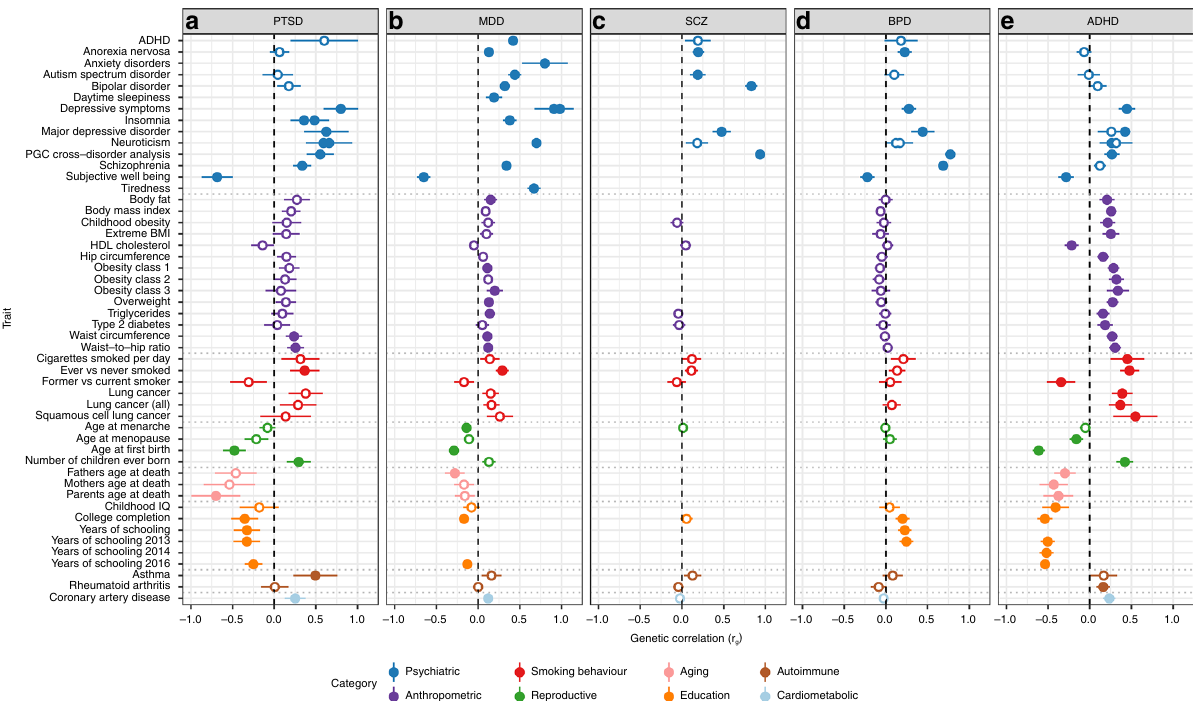
Fig. 3 Commonality of genetic correlations between PTSD and other psychiatric disorders and traits with GWAS summary statistics on LD Hub. Psychiatric traits include a PTSD, b MDD, c SCZ, d BPD and e ADHD and their genetic correlations with traits from psychiatric, anthropomorphic, smoking behavior, reproductive, aging, education, autoimmune and cardiometabolic categories. Only traits with at least one signi fi cant correlation with the 5 psychiatric disorders are shown. Error bars indicate 95% con fi dence limits. Solid points indicate signi fi cant correlation after Bonferroni correction. The total number of correlations tested were 235 for PTSD, 221 for MDD, 172 for SCZ, 196 for BPD and 219 for